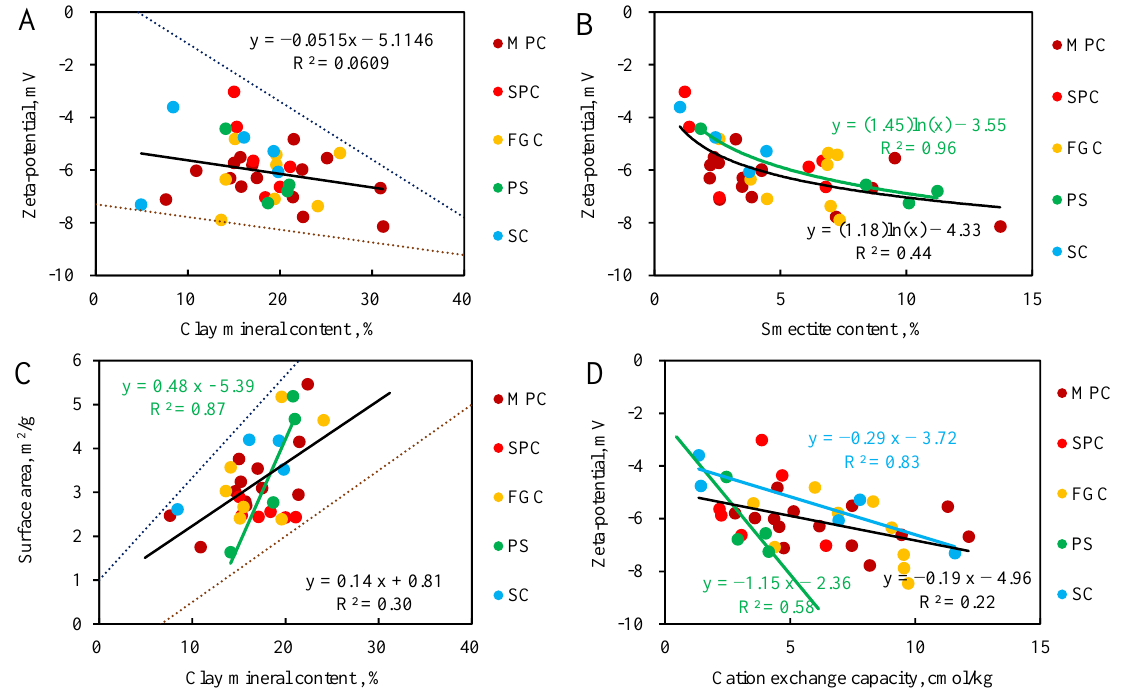
Figure 11. Correlations between reservoir interface properties and clay mineral content in the Mahu area ( A – D ).